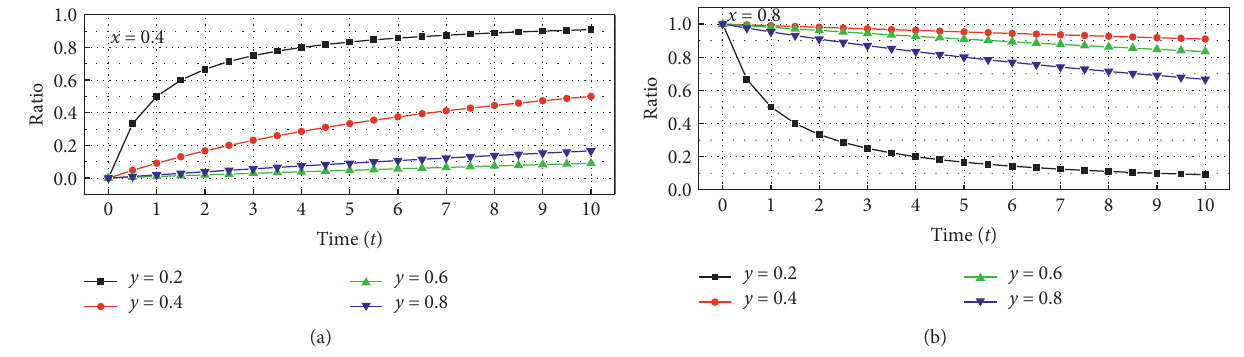
Figure 6: Application platform behavior evolution process.